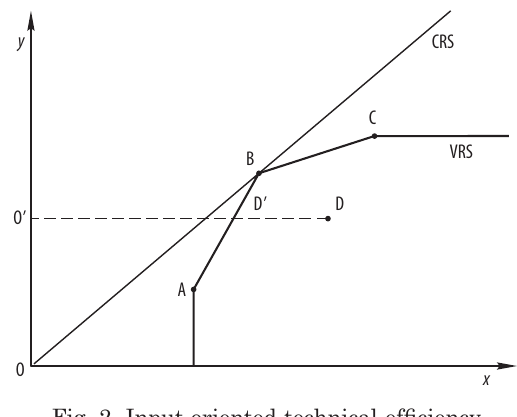
Fig. 2. Input-oriented technical